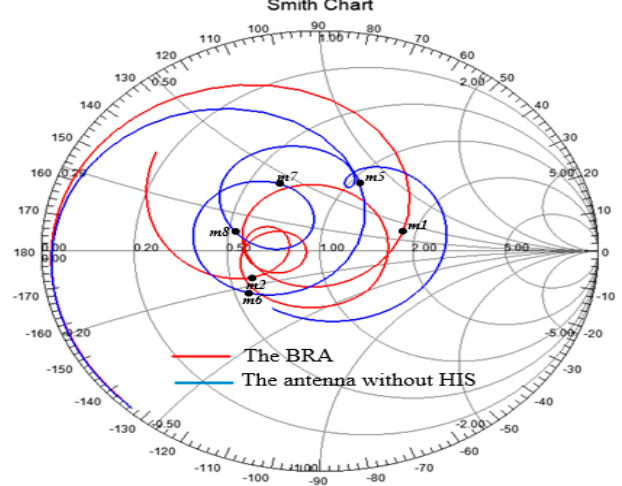
Figure 3. Comparison of input impedance characteristics between the proposed BRA and the antenna without HIS by Smith Chart (marker point: m1, 1.7 GHz; m2, 6.3 GHz; m5, 1.65 GHz; m6, 1.85 GHz; m7, 2.64 GHz; m8, 3.71 GHz).